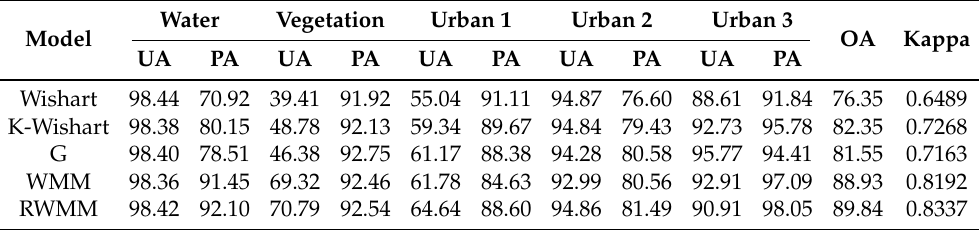
Table 3. The ML-Based Classification Accuracy (%) Comparison of Five Models on the Boao